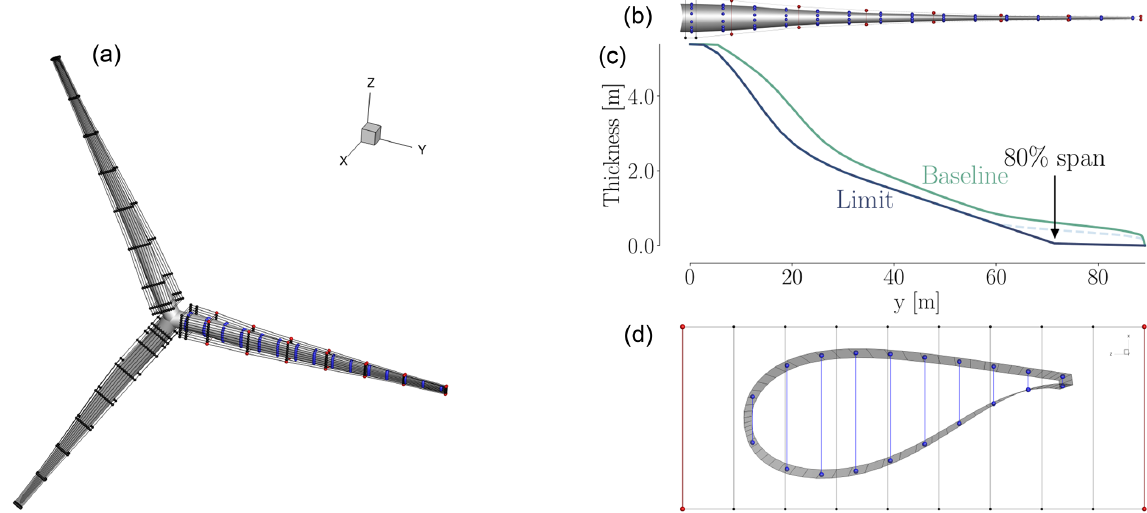
Figure 6. Overview of baseline geometry and FFD boxes (a) . Each FFD box has nine spanwise sections. Each blade (b) has 15 thickness constraints (blue) and seven LE/TE constraints (red). Thickness distributions (c) are for the baseline thickness (green) and minimum allowed thickness (purple). Profile section (d) at 36m span shows the shape control points (20), the thickness constraints (10 blue segments) and LE/TE constraints (two red segments). The LE/TE constraints are only relevant for the full shape